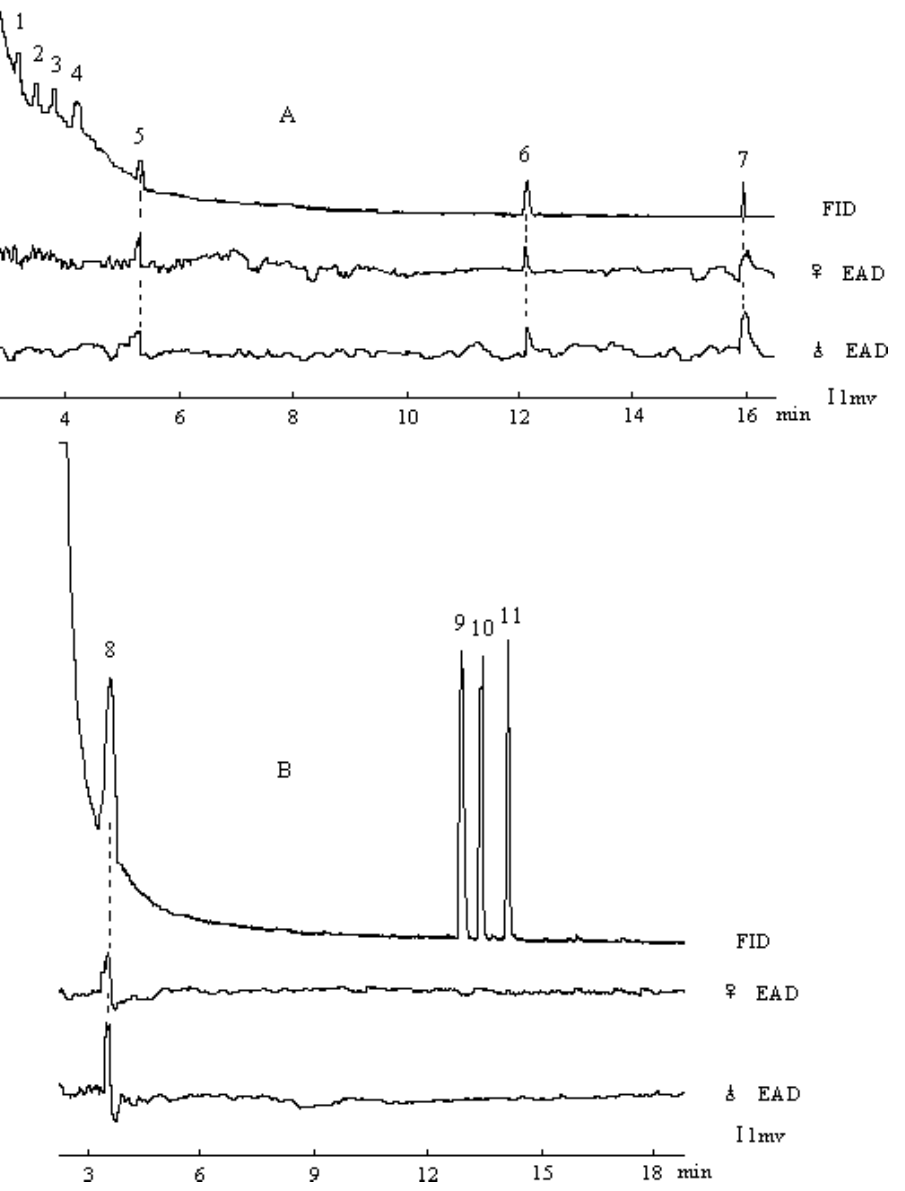
Figure 3. Typical EAD responses of H.parallelusantennae to blend A (A) and B (B). 1 ( + )- a -pinene, 2 ( 2 )- b -pinene, 3 myrcene, 4 ( 2 )-limonene, 5 terpinolene, 6 ( 6 )-myrtenal, 7 ( 6 )-myrtenol, 8 ( + )-3-carene, 9 ( + )- trans -verbenol, 10 ( + )- cis -verbenol, 11 verbenone.